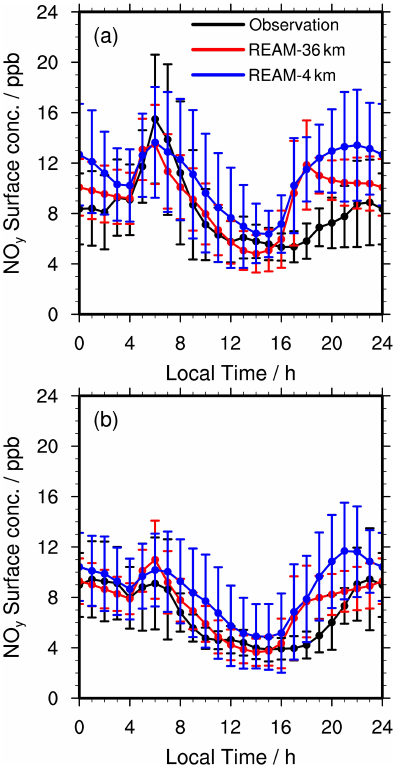
Figure 12. Diurnal cycles of observed and simulated average sur- face NO y concentrations at Padonia, Edgewood, Beltsville, and Aldino on (a) weekdays and (b) weekends. Vertical bars denote the corresponding standard deviations. It is noteworthy that the mean NO x emissions over Padonia, Edgewood, Beltsville, and Aldino are 99% higher in the 4 than the 36km REAM simulations (Table